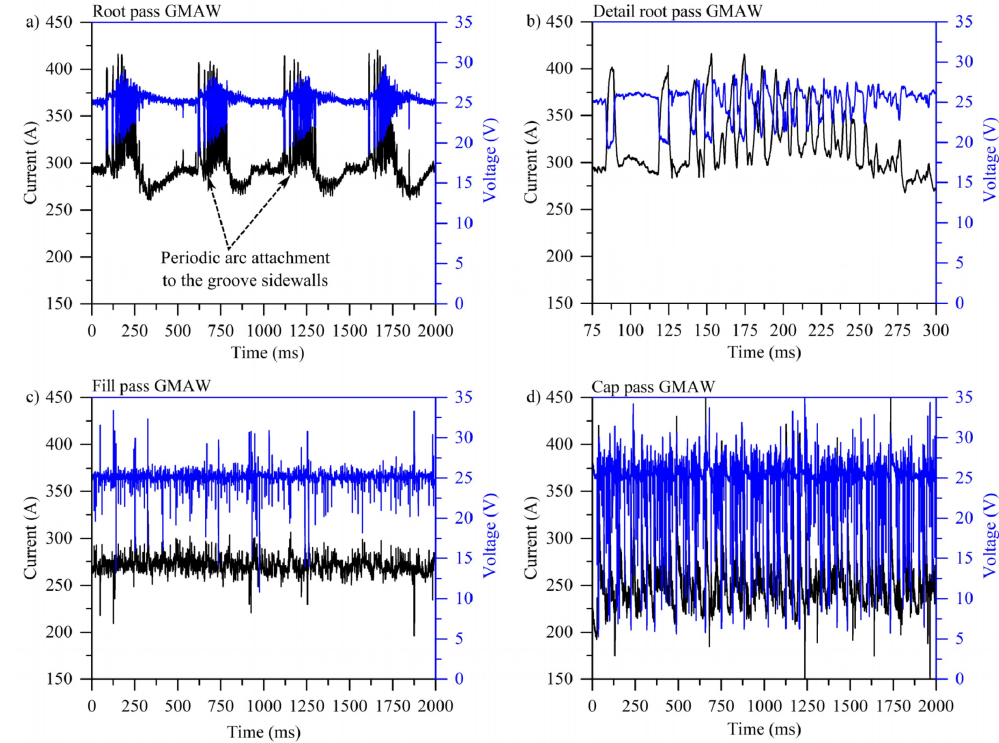
Figure 2. Typical oscillograms for the GMAW condition: ( a ) root pass; ( b ) detail of the root inside the period of repetition; ( c ) fill pass; and ( d ) cap pass.